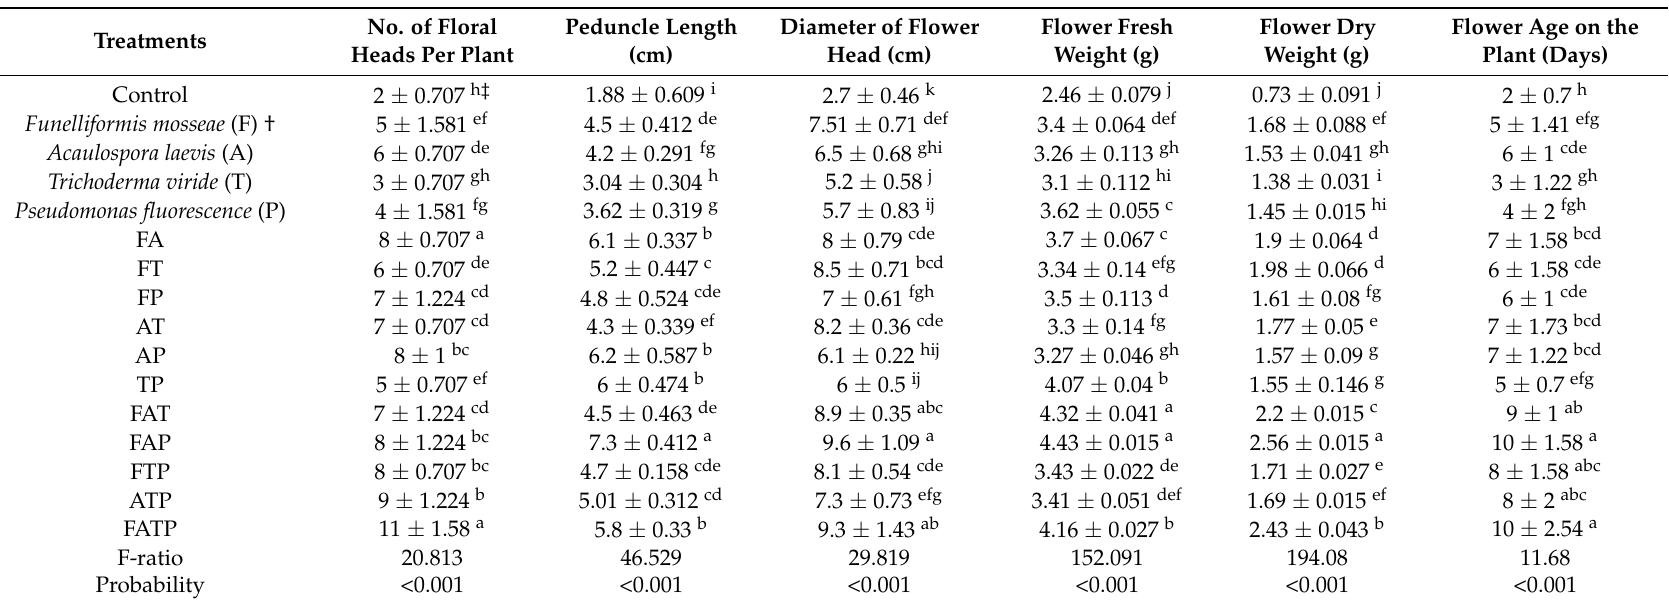
Table 3. Effect of bioinoculants on floral parameters of Gazania rigens